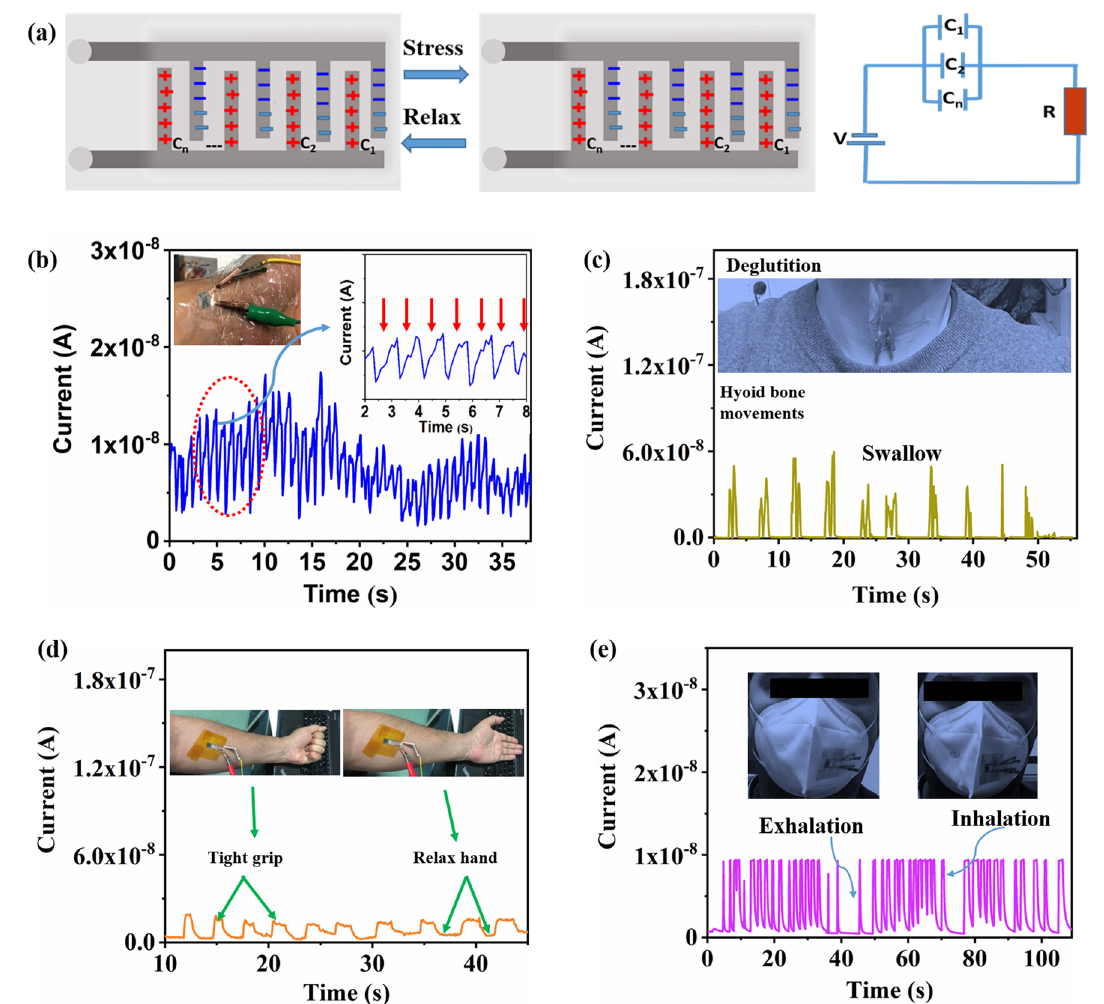
Fig. 7 a Schematic of working mechanism for flexible PPy-CNT@rGO microsensor, b Current variation of micro-strain sensor with wrist pulse, and the inset shows the zoom view of the initial few pulsating electrical waves. c Current variation with hyoid bone movement to observe normal swallowing function. d Arm muscle (flexor) contraction and relaxation. e Pressure variations detection during